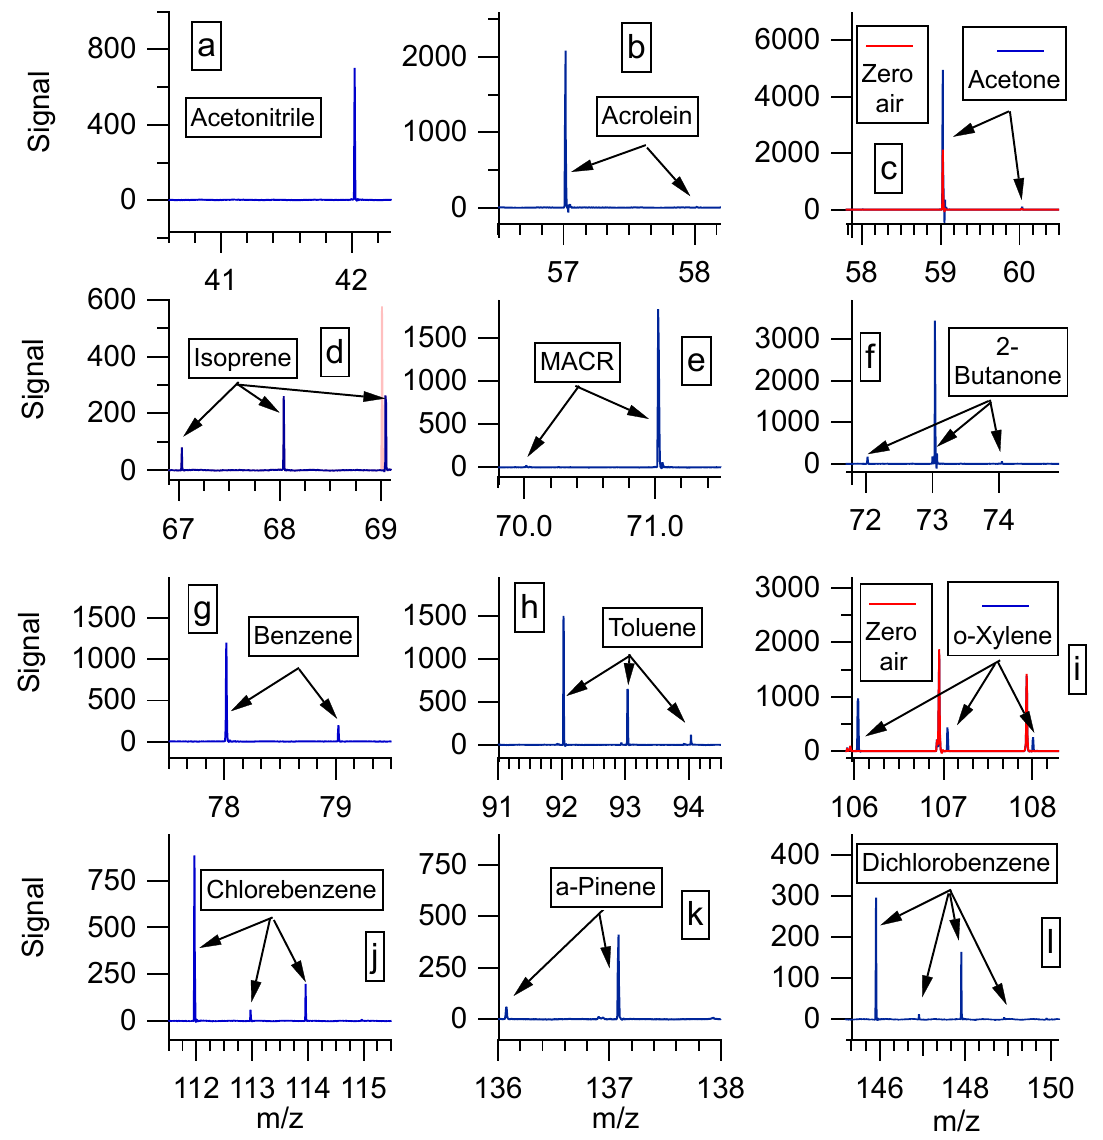
Figure 2. Mass spectra measured by the instrument of selected VOCs at a concentration of 15 ppb. Peaks detected for: ( a ) acetonitrile; ( b ) acrolein; ( c ) acetone; ( d ) isoprene; ( e ) methacrolein; ( f ) 2-butanone; ( g ) benzene; ( h ) toluene; ( i ) o-xylene; ( j ) chlorobenzene; ( k ) a-pinene; ( l ) dichlorobenzene. Methacrolein (C 4 H 6 O) was detected in the protonated form [C 4 H 6 O+H] + ( m/z 71), though a small percentage (1% of the protonated signal) was also observed at m/z 70 in the radical cation form, C 4 H 6 O + (Figure 2e, Table 1). A similar behavior was observed for